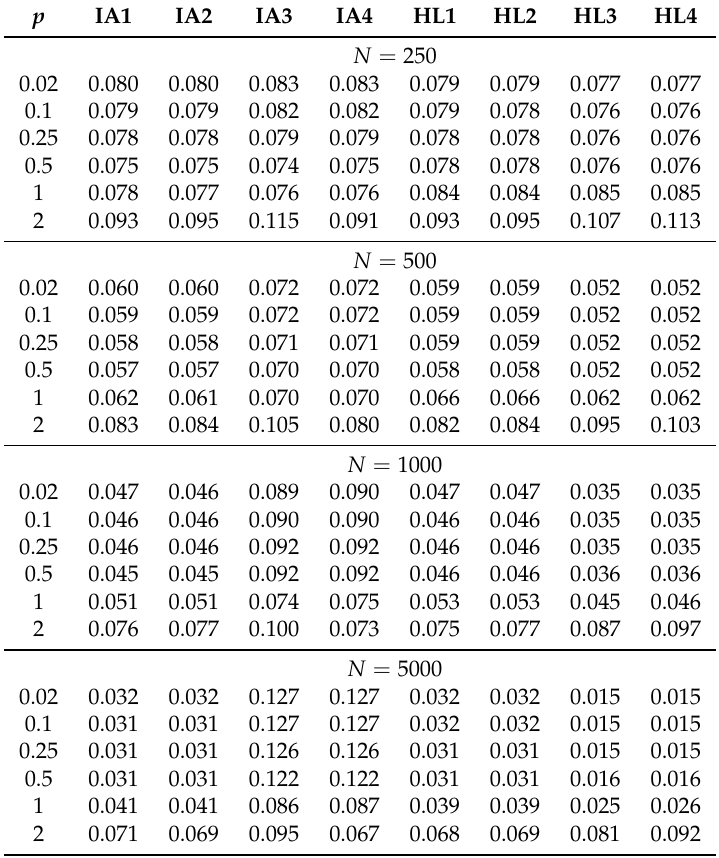
Table 3. Simulation Study 1: Average Root Mean Square Error (ARMSE) of Group Means as a Function of Sample Size in the Condition of Differential Item Functioning (DIF) and G = 18